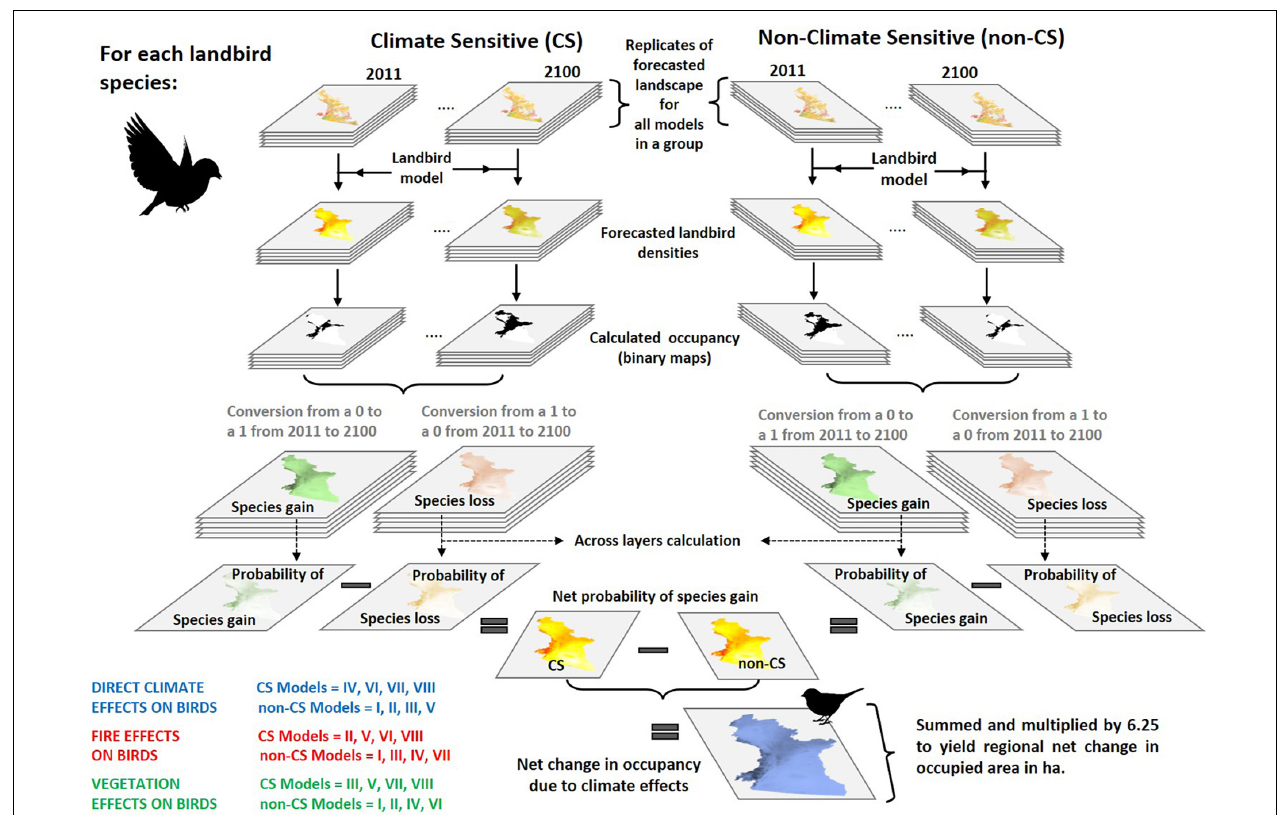
FIGURE 3 | Scheme describing the steps taken to calculate change in occupancy of landbird species by direct and indirect climate effects (summarized in Figure 6 ) from the forecasted